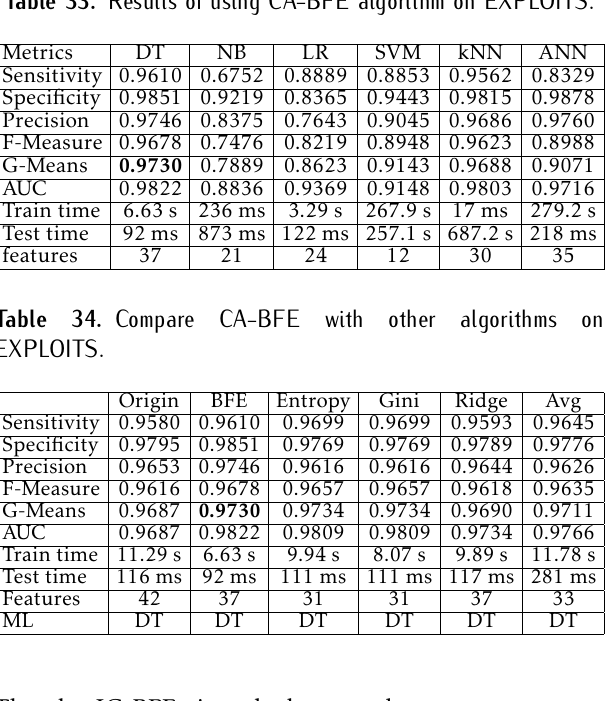
Table 33. Results of using CA-BFE algorithm on EXPLOITS.